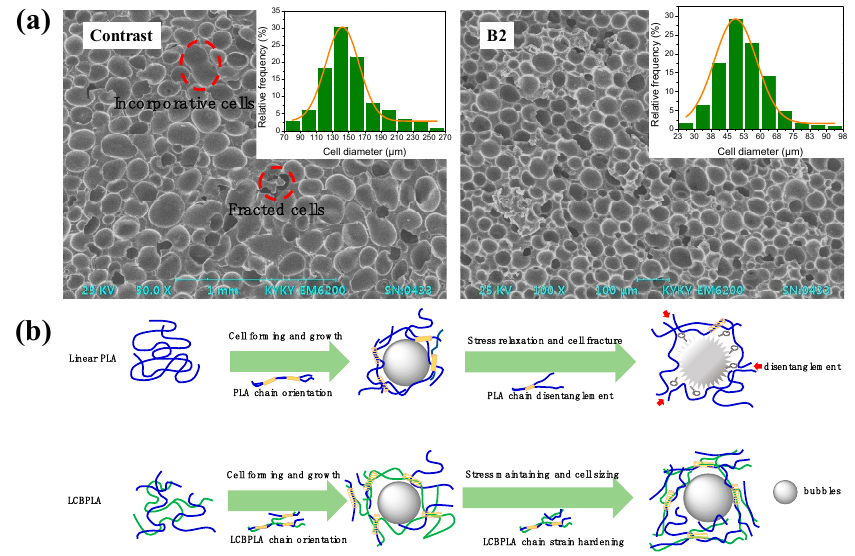
Figure 13. ( a ) SEM images and cell diameter distribution of extrusion foaming PLA; ( b ) Extrusion foaming behavior of linear PLA and LCBPLA melts.